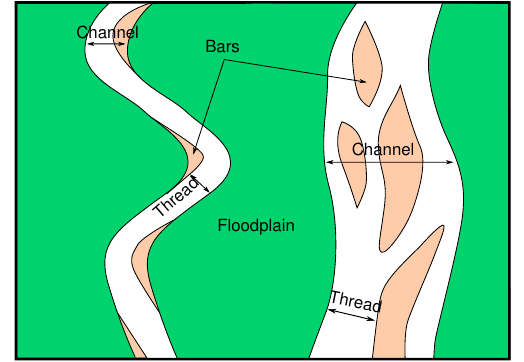
Figure 2. Landsat 5 mosaic image of the Bayanbulak Grassland. Red (meandering) and blue (braided) markers indicate measurement sites. White rectangles correspond to Figs. 4 and 5.